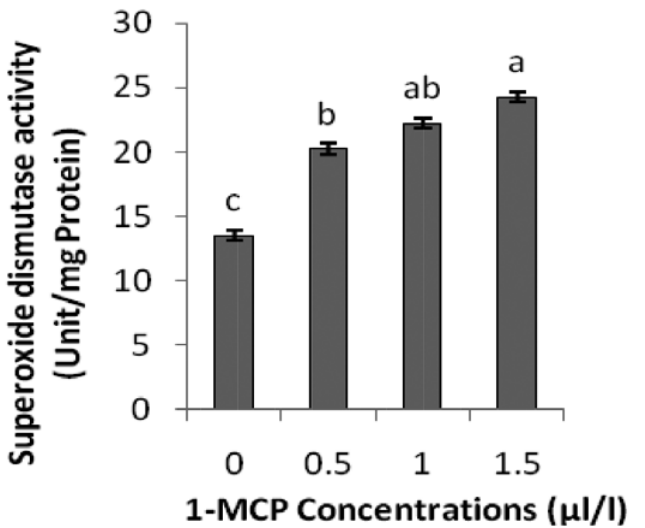
Fig. 7 - Effect of 1-MCP on petal superoxide dismutase enzyme of car- nation cv.